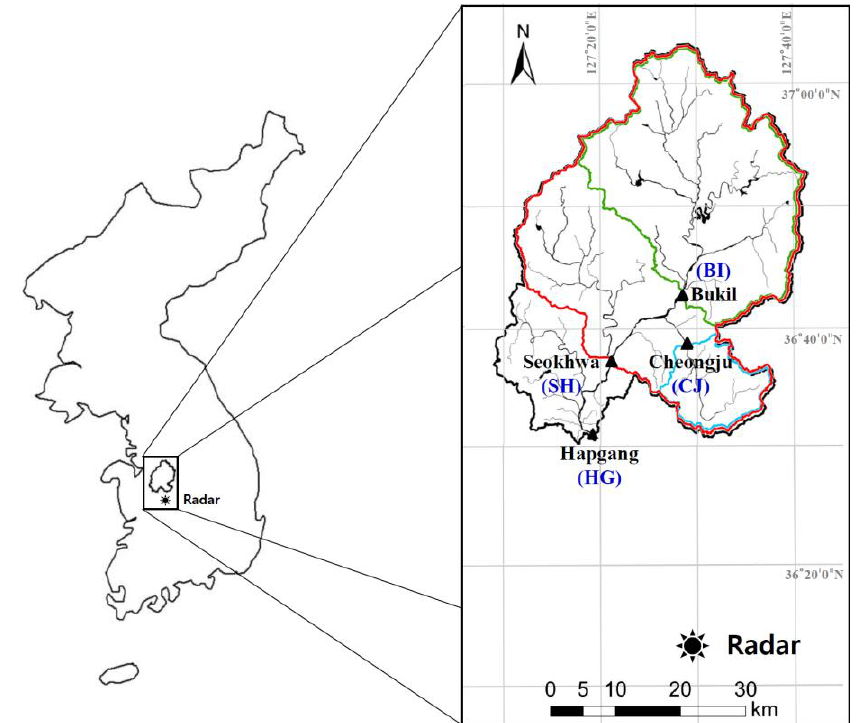
Figure 1. Mihocheon watershed. Black thick line: Hapgang (HG) basin, red line: Seokhwa (SH) basin, green line: Bukil (BI) basin, and blue line: Cheongju (CJ) basin. Triangles: stage-discharge gauging stations. *: Rainfall radar station.